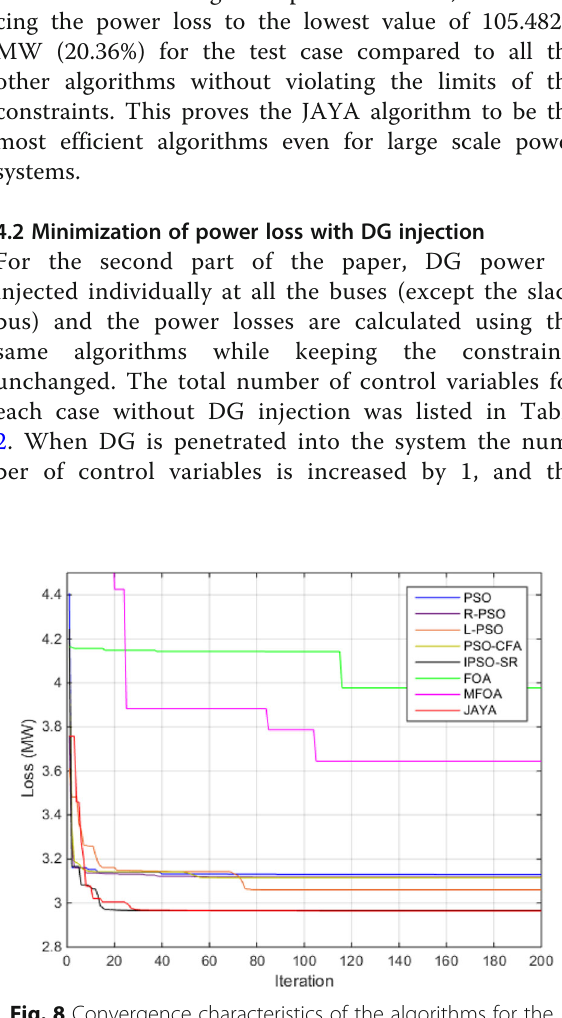
Fig. 8 Convergence characteristics of the algorithms for the IEEE 14 bus system with DG